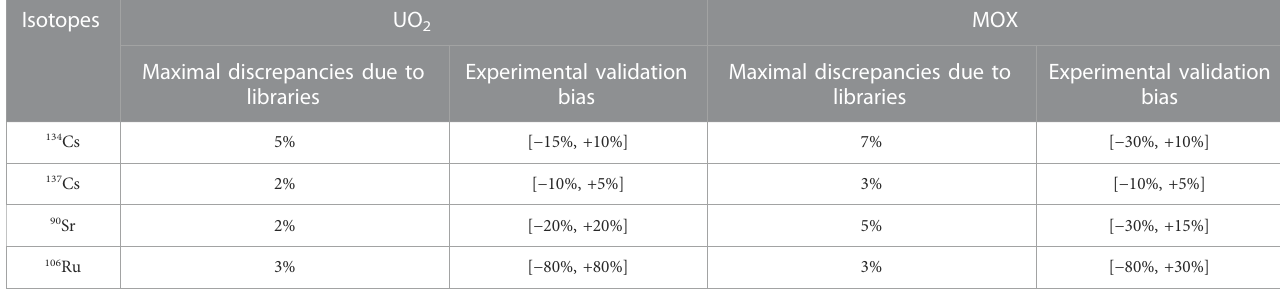
TABLE 4 Maximal nuclear data discrepancies and experimental validation bias for UO 2 (center) and MOX (right) fuel.